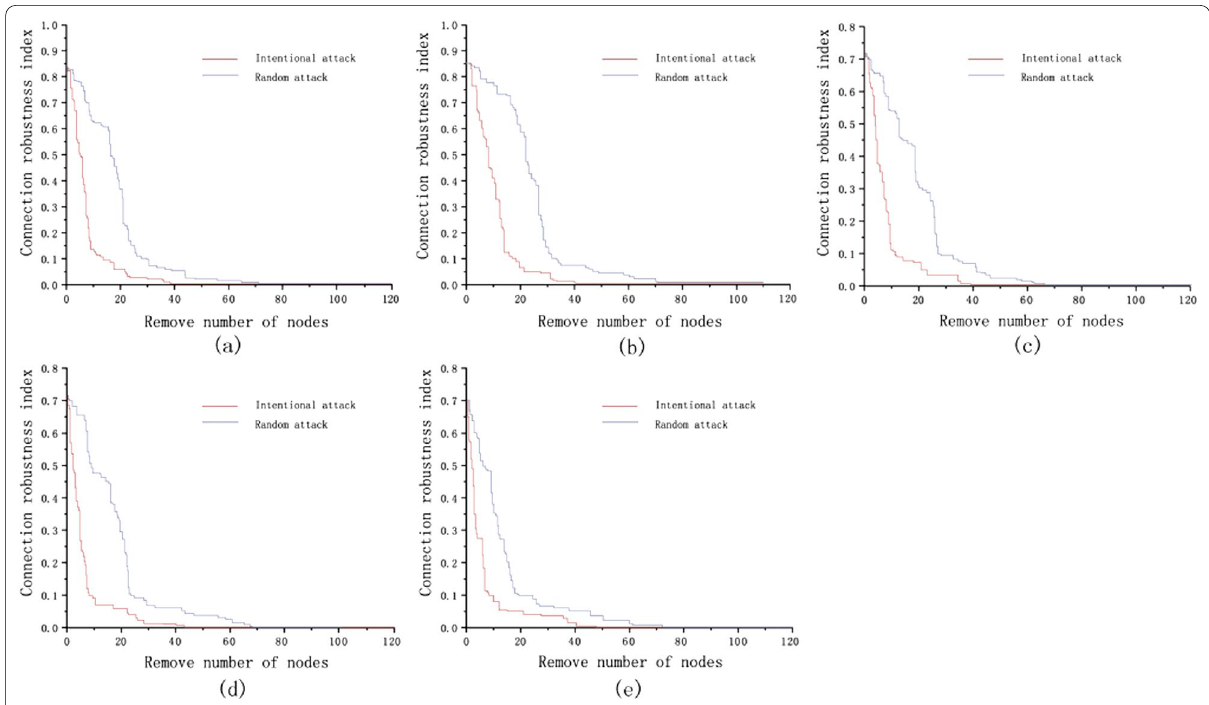
Fig. 6 Connection robustness analysis of the GI network in multiple scenarios. a Current scenario, b 5% economic growth scenario, c 10% economic growth scenario, d 15% economic growth scenario, e 20% economic growth scenario